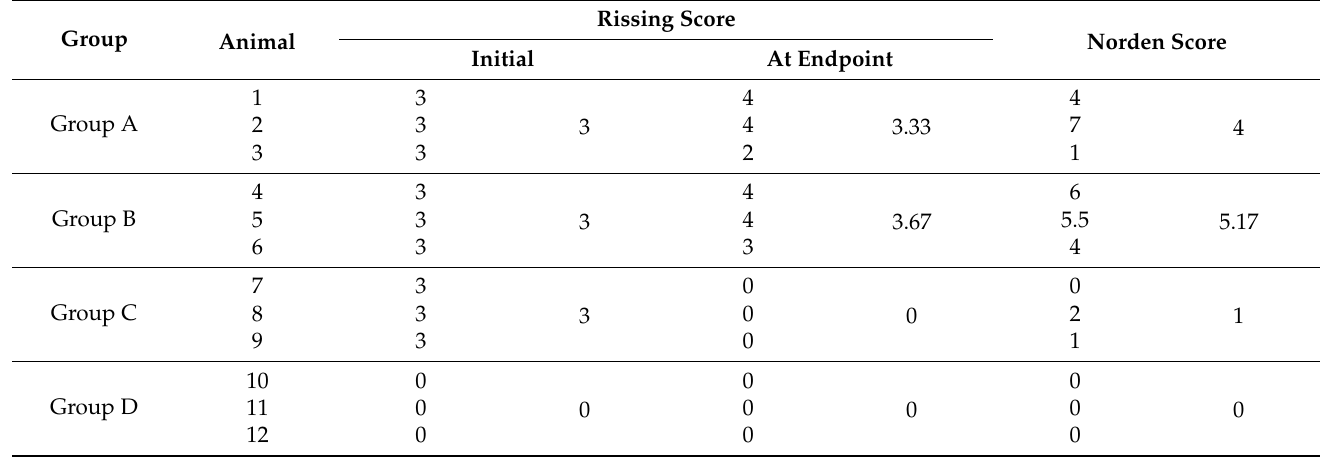
Table 2. Rissing and Norden scores for each animal and group.